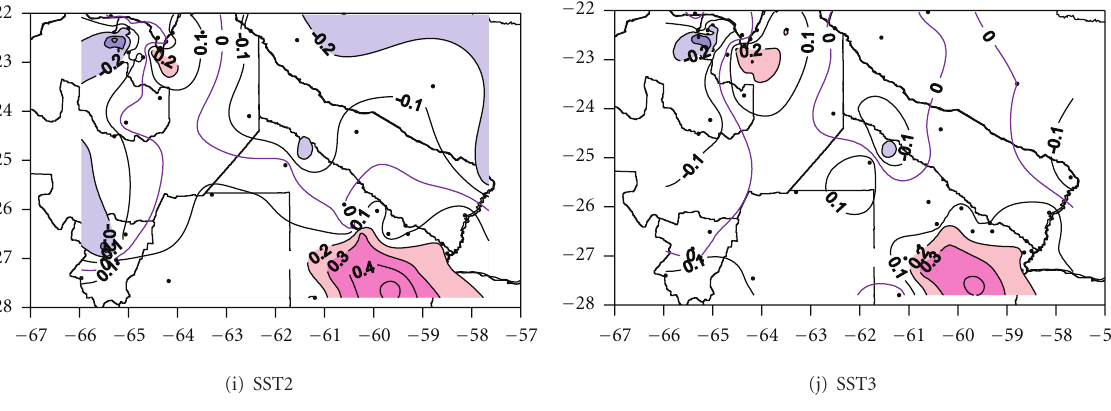
Figure 7: Idem Figure 3 for Annual rainfall.